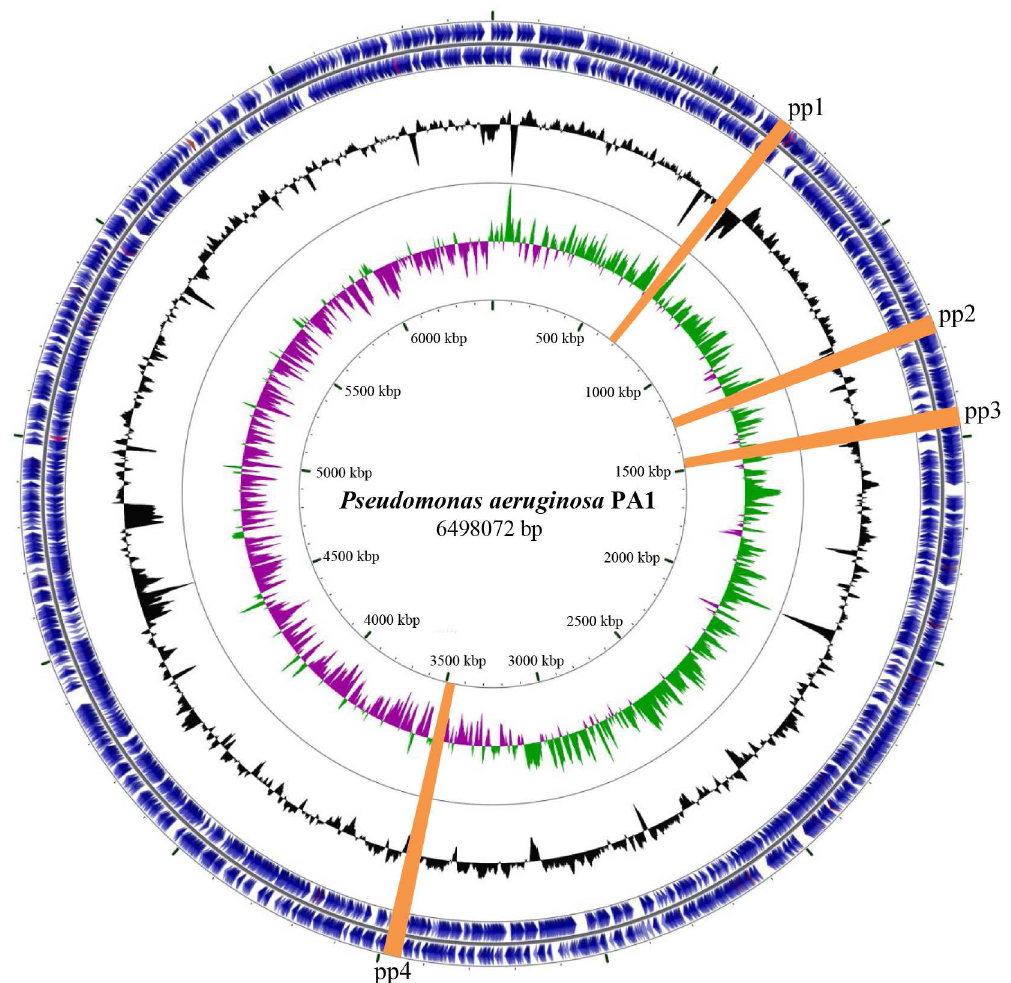
Fig 1. Circular map of the P . aeruginosa PA1 genome. The outermost concentricring shown coding sequences (CDS) in blue on the plus (outer) and minus (inner) strands. tRNA genes are shown in light red and rRNA genesin light purple. Proceeding inwards, the next ring shows local GC content in black as a deviationfrom the average value. GC skew is shown on the next ring using green and purple, and genomecoordinatesare shown on the innermost ring. The predicted prophageclusters are highlightedin orange.